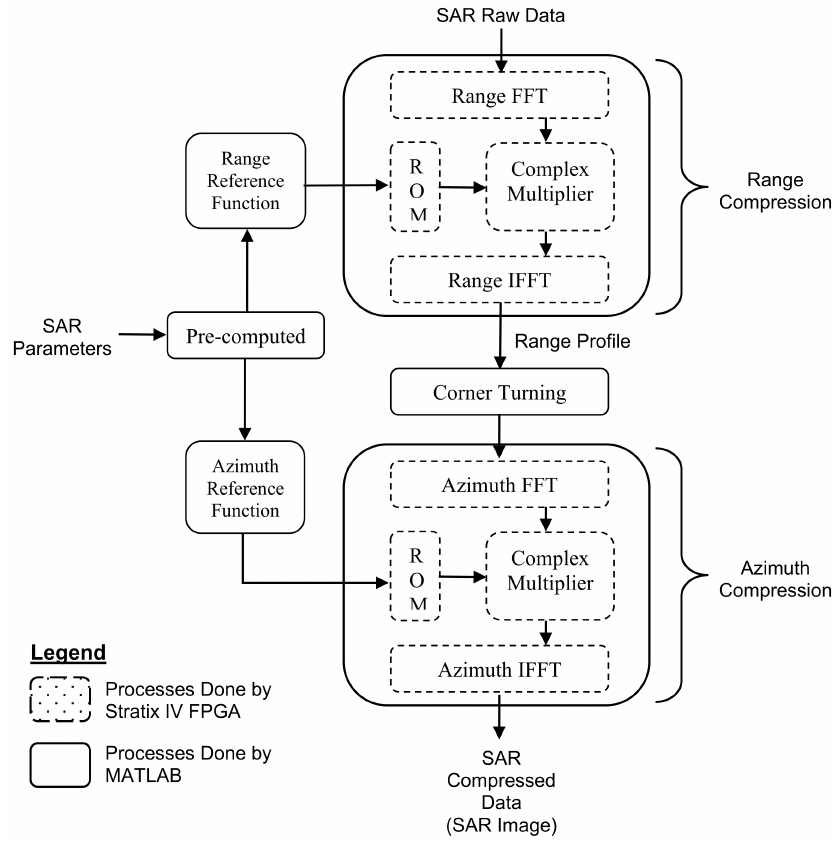
Figure 4. Block-diagram architecture-partitioning of SAR processor.